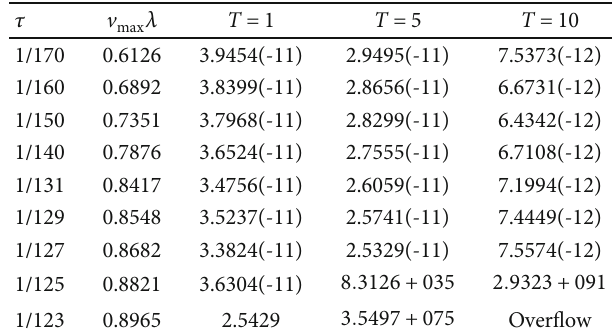
Table 8: The L ∞ norm error with h = for Example